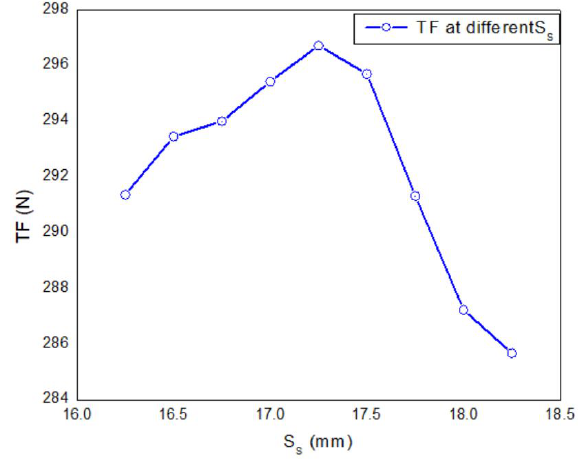
Figure 16. Influence of spacing between the module on TF.